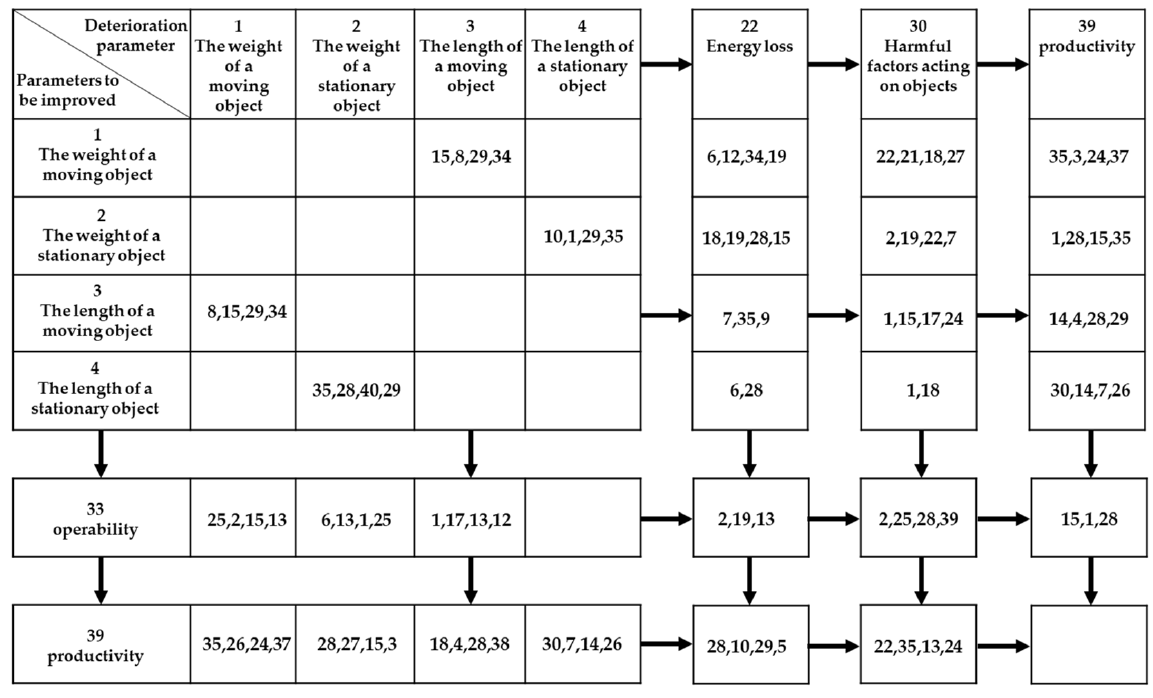
Figure 8. Classical conflict matrix. Table 2. Correspondence between the separation principle and the invention